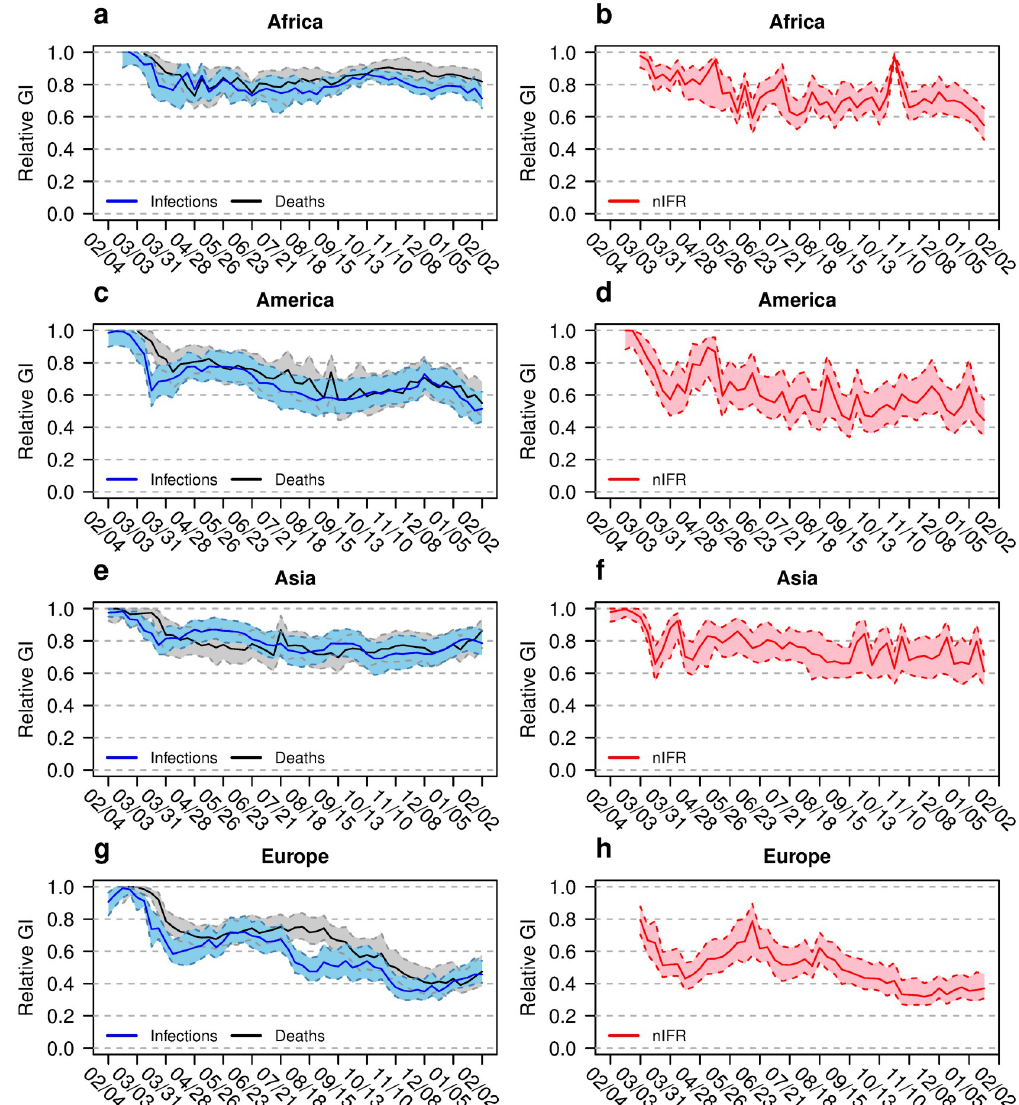
Fig 1. Relative Gini indices for different continents. Relative Gini indices (GI) for infection and death rates (left column) and naive infection fatality rate nIFR (right column) for Africa (a and b), America (c and d), Asia (e and f) and Europe (g and h). The coloured bands show the 95% confidence intervals. The horizontal axis shows the calendar time between February 2020 and February